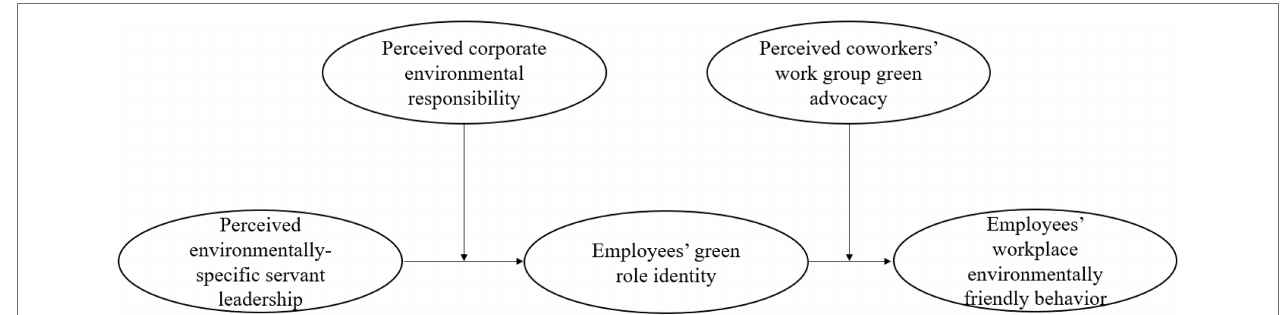
FIGURE 1 | The hypothesized